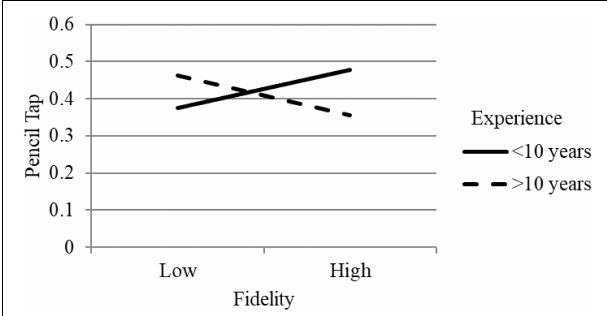
FIGURE 2 | Moderated effect of implementation fidelity on children’s pencil tap scores by teacher years of experience.